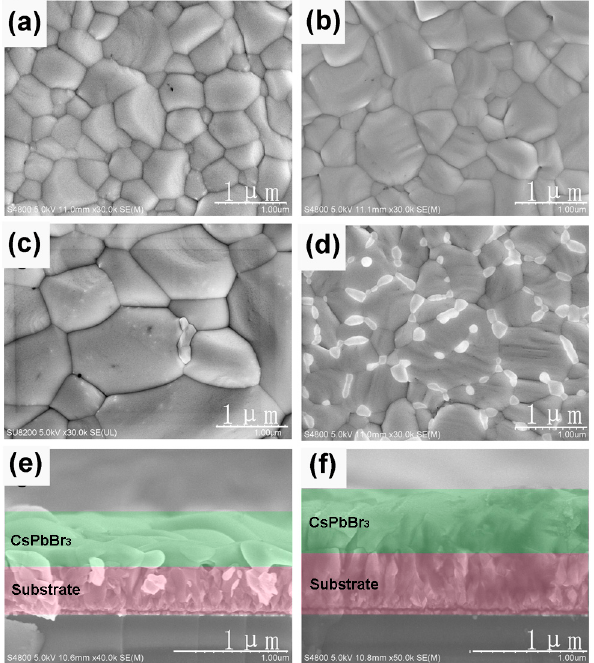
Figure 2. Top-view SEM images of CsPbBr 3 films ( a ) undoped and doped with PEAI at ( b ) 5, ( c ) 10, and ( d ) 15 mg/mL. Cross-sectional SEM images of CsPbBr 3 films ( e ) undoped and ( f ) doped with 10 mg/mL PEAI.